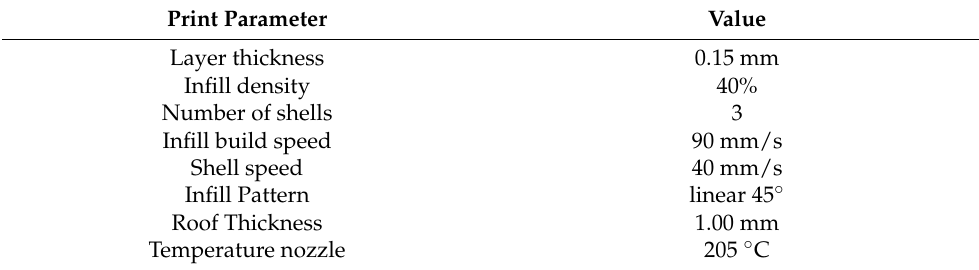
Table 2. The print parameters of the test specimens.